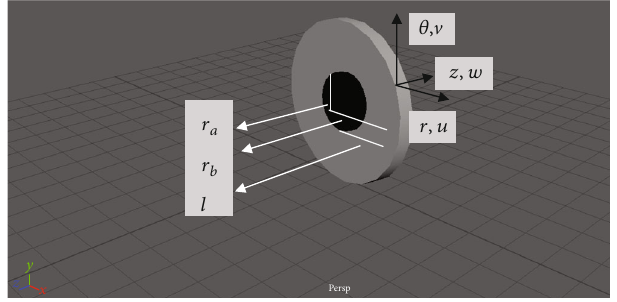
Figure 1: Various deformation